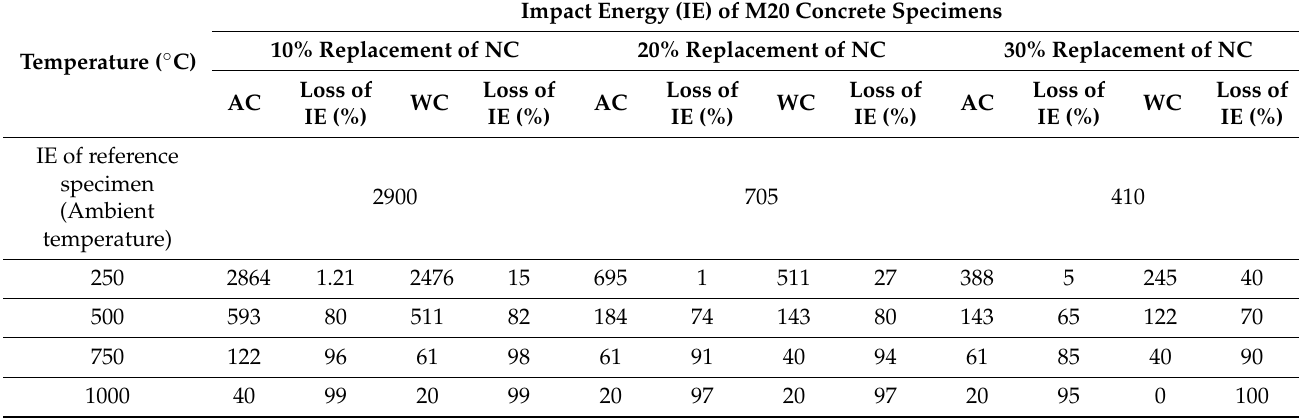
Table 4. The impact energy of specimens cast with NC.